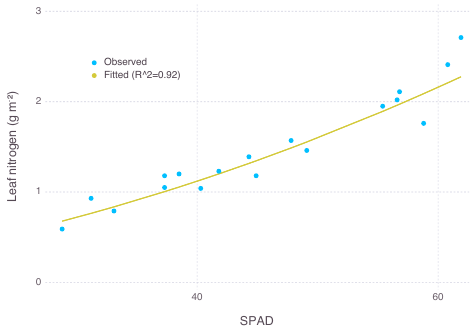
Figure A6. Fitting SPAD measurement to leaf nitrogen content ( N ). N was fitted by a quadratic equation N = 0.0004 x 2 + 0.012 x for 18 samples of SPAD measurement ( x = SPAD) with R 2 = 0.92.